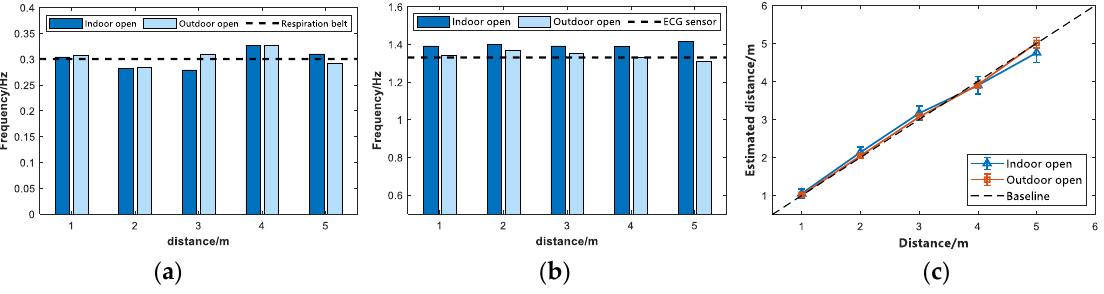
Figure 6. Indoor environment. ( a ) Respiratory rate estimation. ( b ) Heartbeat frequency estimation. ( c ) Range estimation.